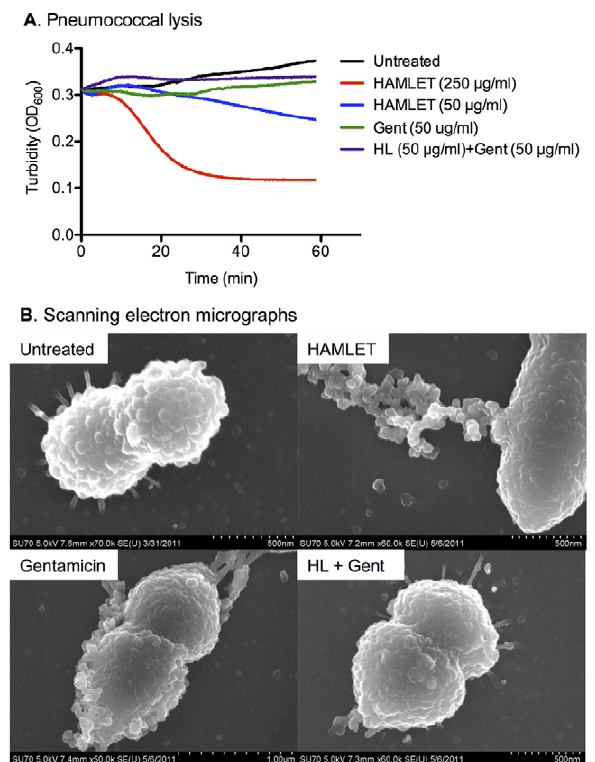
Figure 7. Autolysis during HAMLET-gentamicin combination therapy. (A) Optical density at 600 nm of S. pneumoniae D39 (black line) after exposure to a lethal concentration of HAMLET (250 m g/ml; red line), a sublethal concentration of HAMLET (50 m g/ml; blue line), a sublethal concentration of gentamicin (50 m g/mL; green line) or the combination of sublethal concentrations of HAMLET and gentamicin (purple line) that resulted in complete death of the inoculum. The data shows a representative experiment. (B) Representative scanning electron micrographs of untreated S. pneumoniae D39, as well as bacteria treated 4 minutes with a lethal concentration of HAMLET (250 m g/mL), one hour with a similarly lethal concentration of gentamicin (500 m g/mL) or one hour with a sublethal concentration of HAMLET (50 m g/mL) or a sublethal concentration of gentamicin (50 m g/mL) in combination (HL + Gent). Note the numerous defects of the pneumococcal cell wall after exposure to HAMLET or gentamicin alone compared with the structurally intact cells after exposure to the combination of the two agents. MIC for penicillin was reduced over 32-fold to 1.56 m g/ml for strain 7169 and over 4-fold to 12.5 m g/mL for BC8 ( Table 1 ). The MIC for gentamicin was 25 m g/ml in both strains. In the presence of 50 m g/ml of HAMLET the reduction in gentamicin MIC in these strains was also significant, but less pronounced (about 4-fold; Table 1 ). Similarly, treatment of A. baumanii AB307 and AB979 that had MICs for HAMLET that exceeded 1,000 m g/ml and MICs for penicillin that exceeded 100 m g/ml, the presence of 50 m g/ml of HAMLET reduced the MIC of penicillin 4-fold for both strains ( Table 1 ). The MICs for gentamicin was 36 m g/ml and 2.5 m g/ml for strains AB307 and AB979, respectively, which were lowered 8-fold and 2-fold respectively in the presence of 50 m g/ml of HAMLET ( Table 1 ).